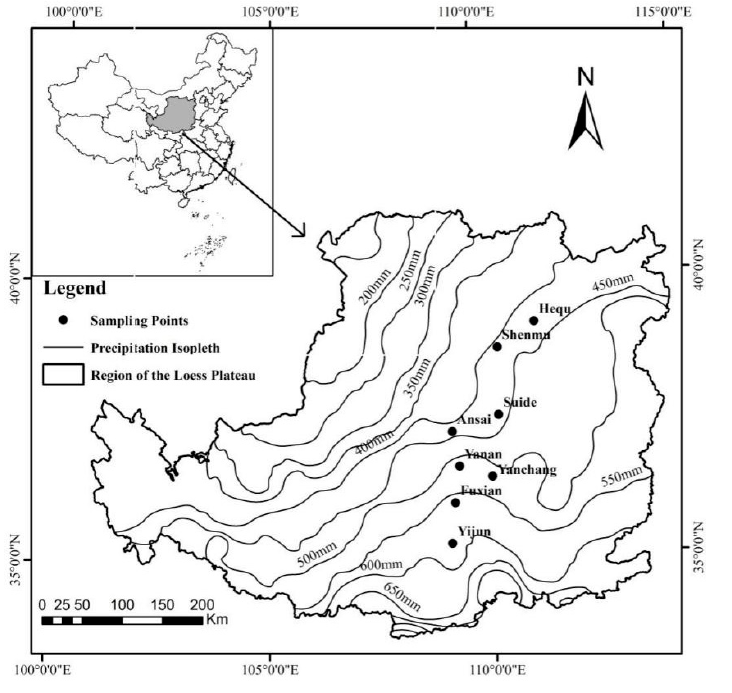
Figure 1. Distribution of soil-moisture-sampling points on the Loess Plateau of China.